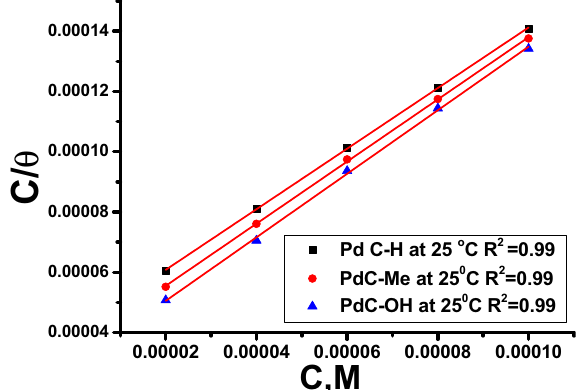
Figure 4. Langmuir isotherms draw as [C/θ] vs. [C] of (PdC-H, PdC-Me and PdC-OH) for corrosion of carbon steel in 1 M HCl at 25 °C.